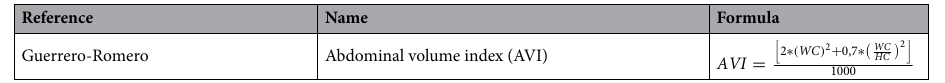
Table 1. Index formula and its structure. WC waist circumference, HC hip